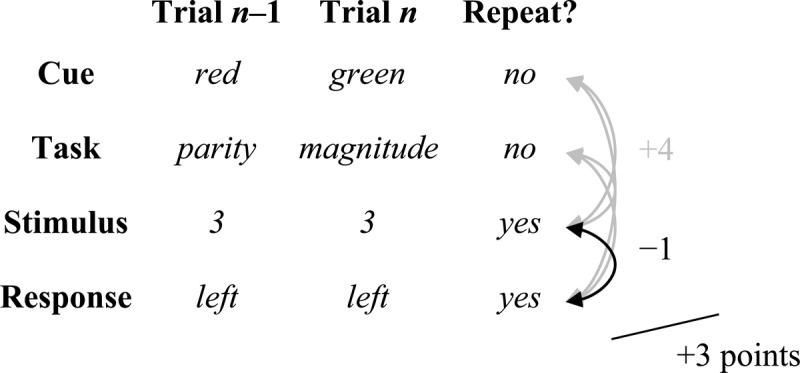
The Altmann model as it applies to cued task switching. Repeated features paired with another repeated feature count as –1 point, and repeated features paired with a non-repeated feature count as +1 point. There are no points for pairs of non-repeated features (e.g., the cue and task in this example). The example is of alt-RR trials, but each trial type is computed the same way.